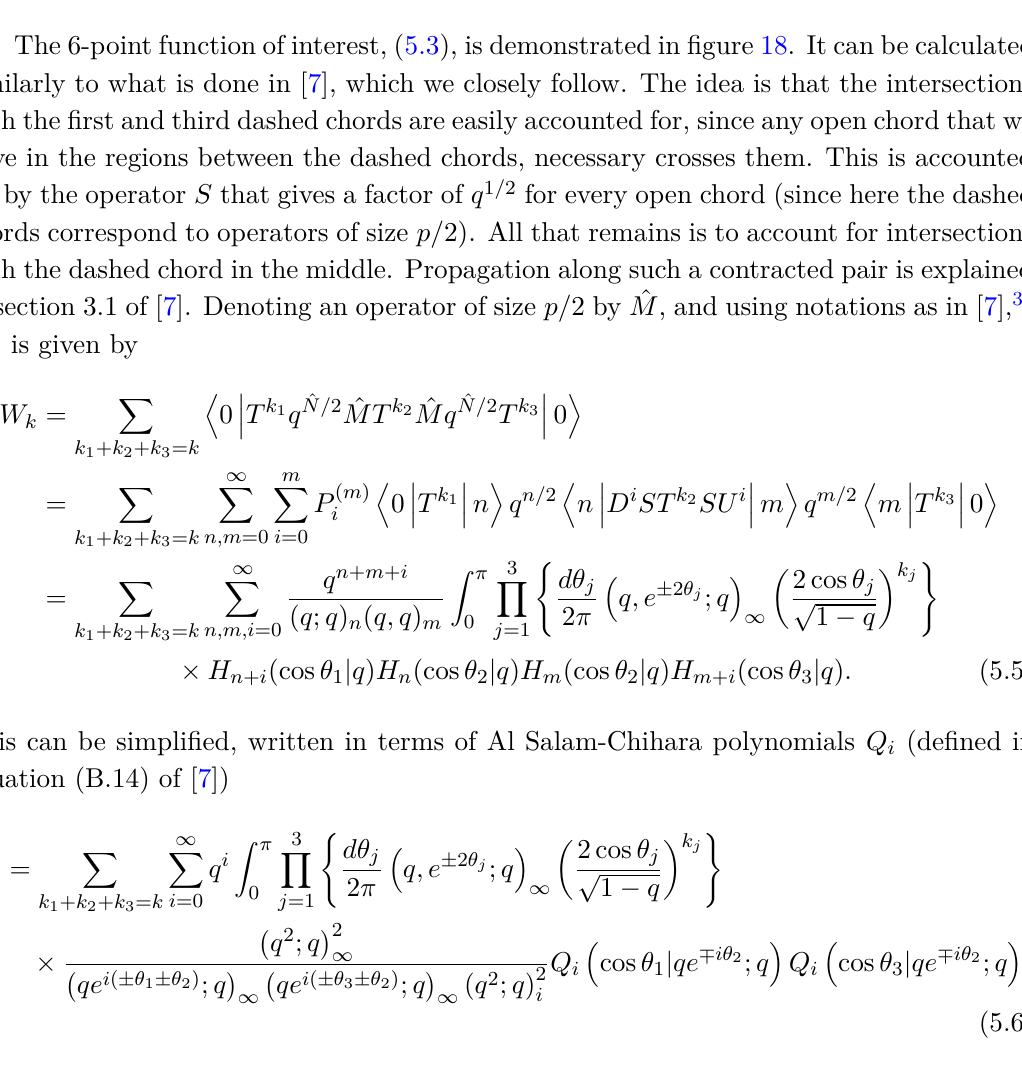
Figure 18 . A demonstration of the 6-point function that is needed for the calculation of odd